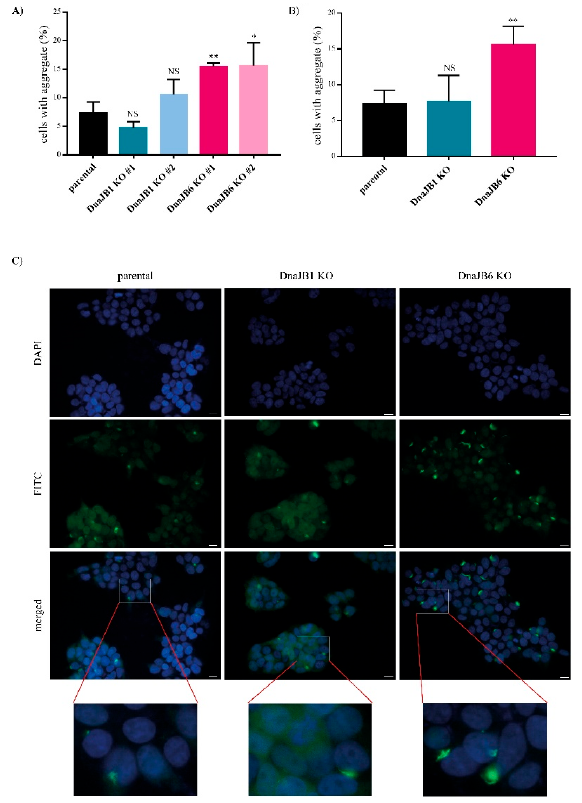
Figure 2. α -Syn pre-formed fibrils (PFFs)-induced aggregation in DNAJB1 KO, DNAJB6 KO, or parental control α -Syn CFP / YFP HEK293 cells, analyzed by immunofluorescence microscopy. ( A ) Quantifications of the percentage of cells positive for fluorescent aggregates in parental cells (7.36 ± 1.07), and two di ff erent individual clones of DNAJB1 (4.68 ± 0.629 and 10.5 ± 1.53) or DNAJB6 KO (15.5 ± 0.31 and 15.6 ± 2.3), respectively. ( B ) These numbers were averaged for the two independent clones of each KO (7.61 ± 1.5 and 15.6 ± 1.04), respectively. The data were analyzed by the Student’s t -test, and are represented as mean ± standard deviation (SD), namely: ns p > 0.05 * p < 0.05; ** p < 0.01 ( n = 3). ( C ) Representative pictures of DAPI stained of parental, DNAJB1 KO, and DNAJB6 KO α -Syn CFP / YFP HEK293 cells. The cells were transfected with 10 nM α -Syn PFFs for 48 h, prior to these analyses. Scalebar: 20 µ